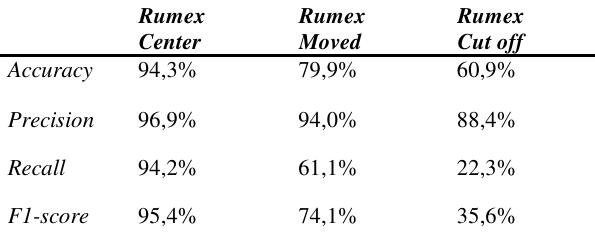
Table 2. Validation measures of the basic model